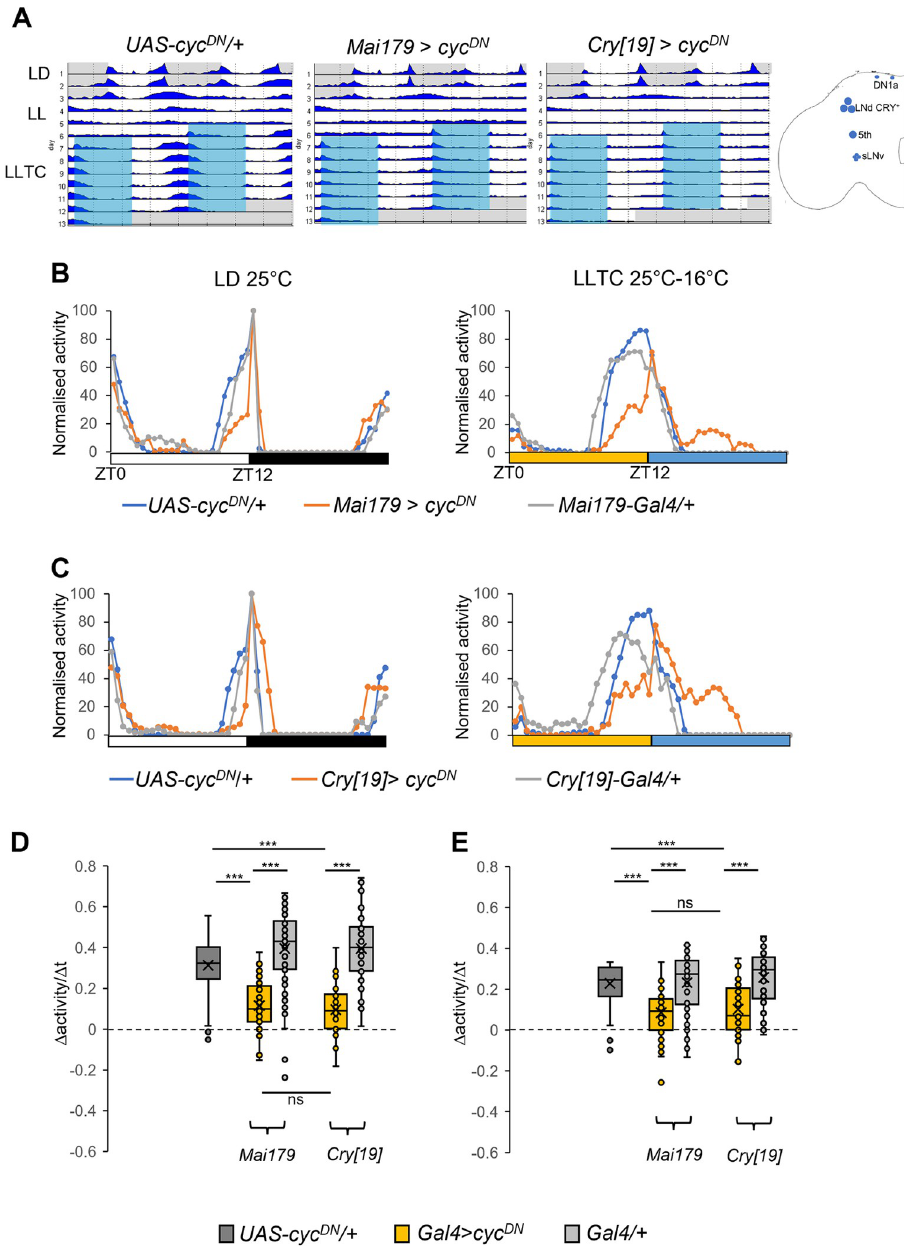
Fig 1. MO and EO circadian clocks are required for synchronization to temperature cycles in constant light. Male flies were synchronized to LD 25˚C for two days, before being exposed to LL 25˚C for three days, followed by temperature cycles in LL (LLTC 25˚C:16˚C), which were delayed by 5-h compared to the initial LD cycle. A) Double plotted average actograms of one representative experiment. N: UAS-cyc DN /+ = 19, Mai179 > cyc DN = 21, cry[19] > cyc DN = 22. Conditions are indicated to the left. White areas indicate lights on and 25˚C, grey areas lights off and 25˚C during LD, and blue areas lights-on and 16˚C during LLTC. Cartoon on the right shows clock neurons expressing Mai179 and cry[19] drivers. B-C) Median of normalized locomotor activity during the last day of LD (left) and the 6 th day of LLTC (right). White bars represent lights-on, black bar lights off in LD (left), yellow and blue bars indicate thermophase (25˚C) and cryophase (16˚C) in LL, respectively (right). N: UAS-cyc DN /+ = 59, Mai179 > cyc DN = 55, Mai179-Gal4 /+ = 59. C) N: UAS-cyc DN /+ = 36, cry[19] > cyc DN = 44, cry[19]-Gal4/+ = 47. D-E) Box plots showing the slope of the evening peak on the last day of LD (D) and the 6 th day of LLTC (E). The slope is calculated as follows: (Act max − Act ZTmin ) / (ZT max − ZT min ), with ZT min being the last time point of the minimum median value and ZT max the first time point with the maximum value before startle response to Zeitgeber change. N: UAS-cyc DN /+ = 95 (B+C). For other genotypes see B-C. D) UAS-cyc DN /+: ZT min 8.5, cry[19] - Gal4 /+: ZT min 9.5, Mai179 > cyc DN , Mai179-Gal4